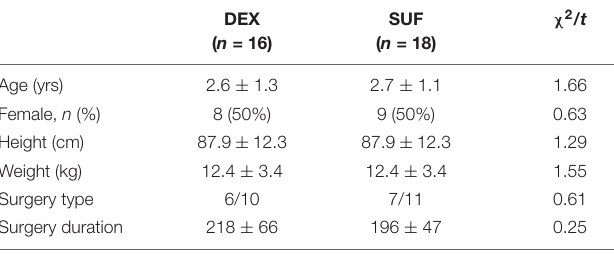
TABLE 1 | Demographic characteristics of patients aged 1–6 years old in the SUF and DEX experimental groups.